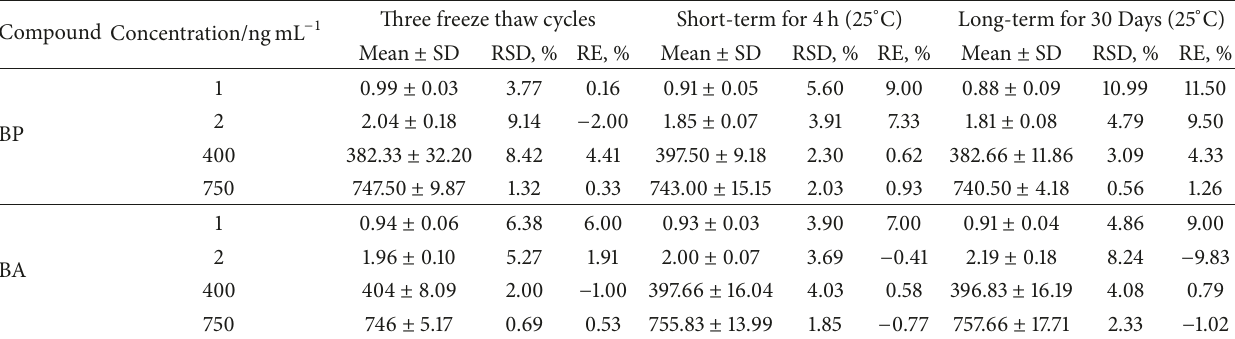
Table 4: BP and BA stability in QC samples ( 𝑛 = 6